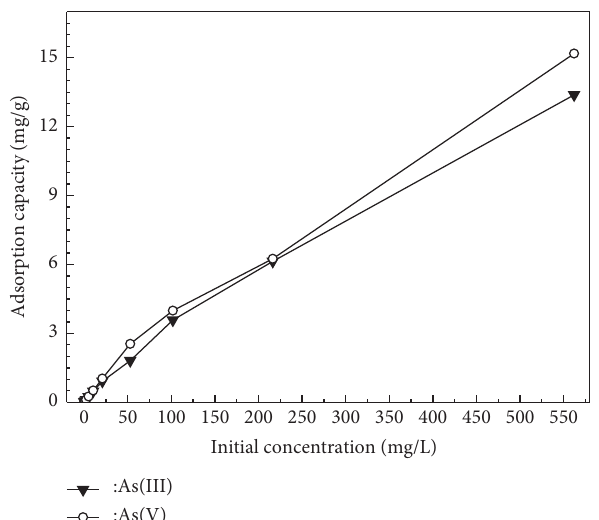
Figure 10: Adsorption isotherms of arsenic by TiO